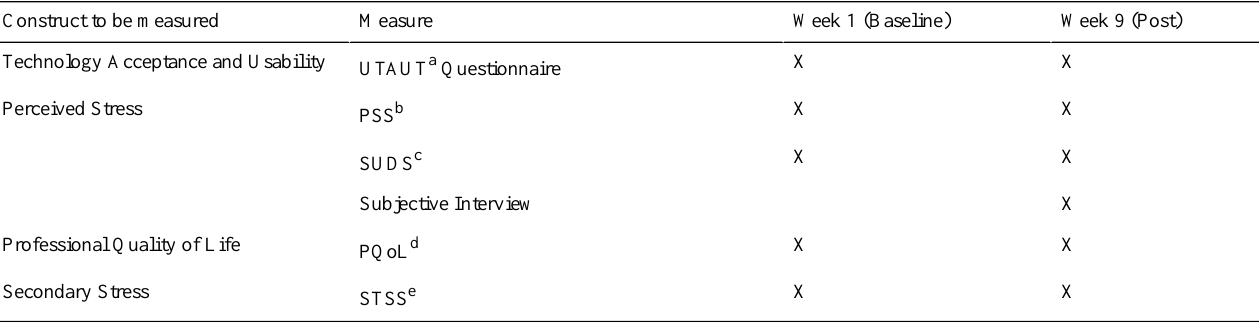
Table 2. Time points of data collection for multimodular motion-assisted memory desensitization and reconsolidation (3MDR) clinicians and